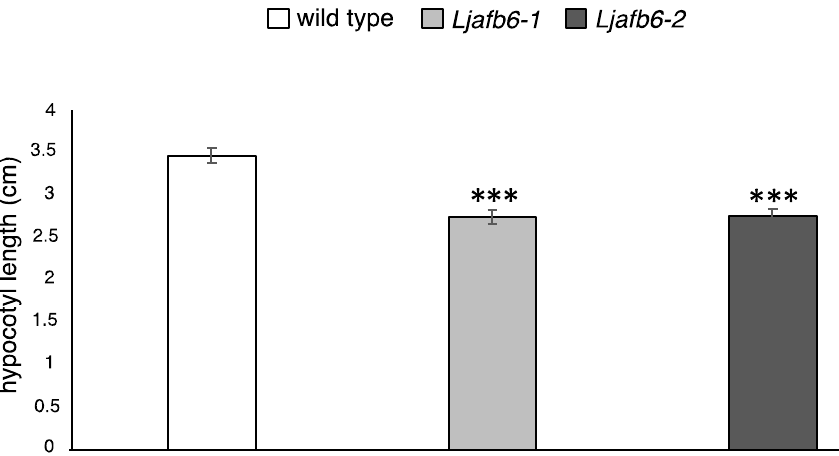
Figure 8. Phenotypic characterization of Ljafb6-1 and Ljafb6-2 mutants. Hypocotyl length of wild type and Ljafb6 etiolated seedlings maintained for 2 weeks in the dark. Asterisks indicate significant differences between plant genotypes. *** p < 0.0001